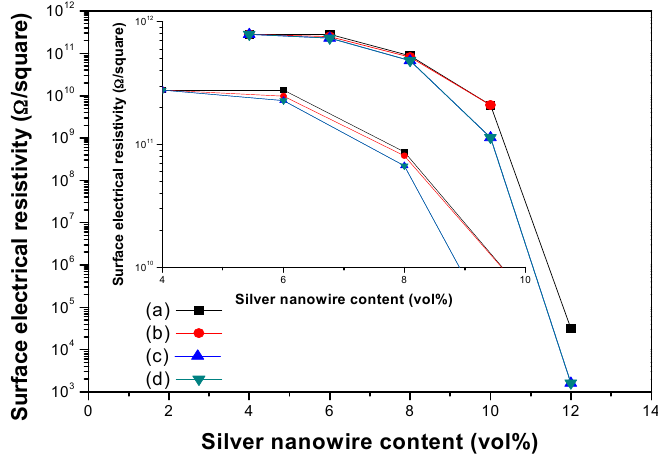
Figure 4. Surface electrical resistivity of the cured epoxy resin containing AgNWs of various concentrations: ( a ) sample cured with imidazole in the direction of the highest resistivity; ( b ) sample cured with imidazole in the direction perpendicular to that of ( a ); ( c ) sample cured with silver–imidazole complex in the direction of the highest resistivity; ( d ) sample cured with silver–imidazole complex in the direction perpendicular to that of ( c ).